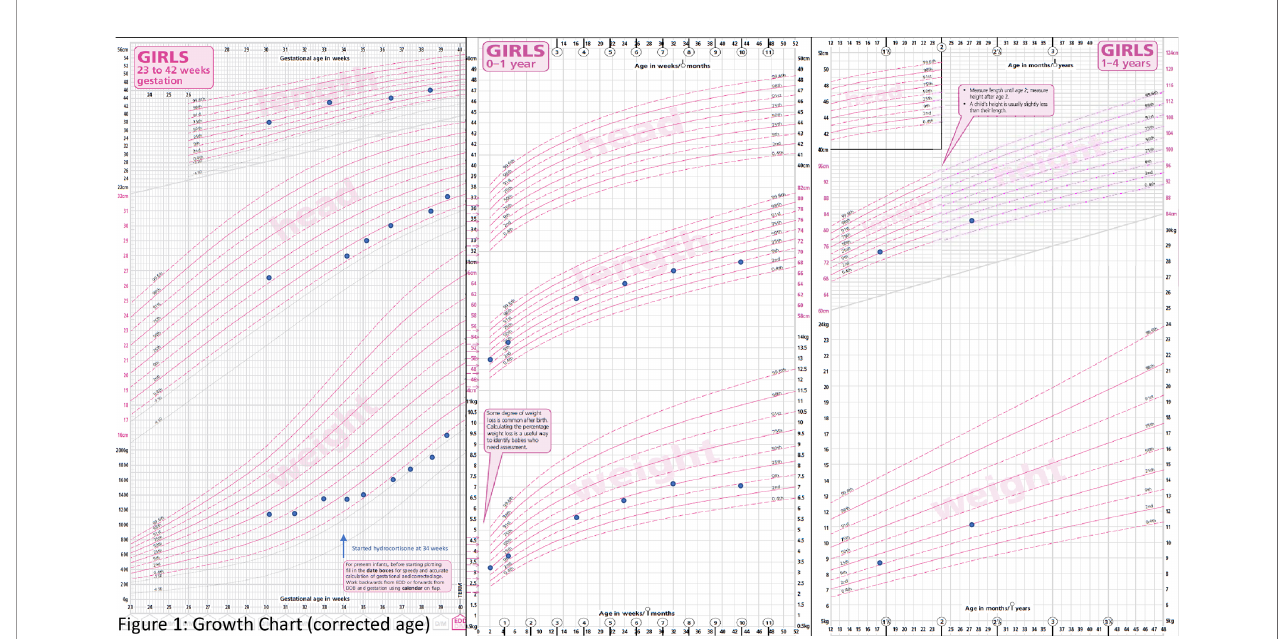
FIGURE 1 | Growth Chart (corrected